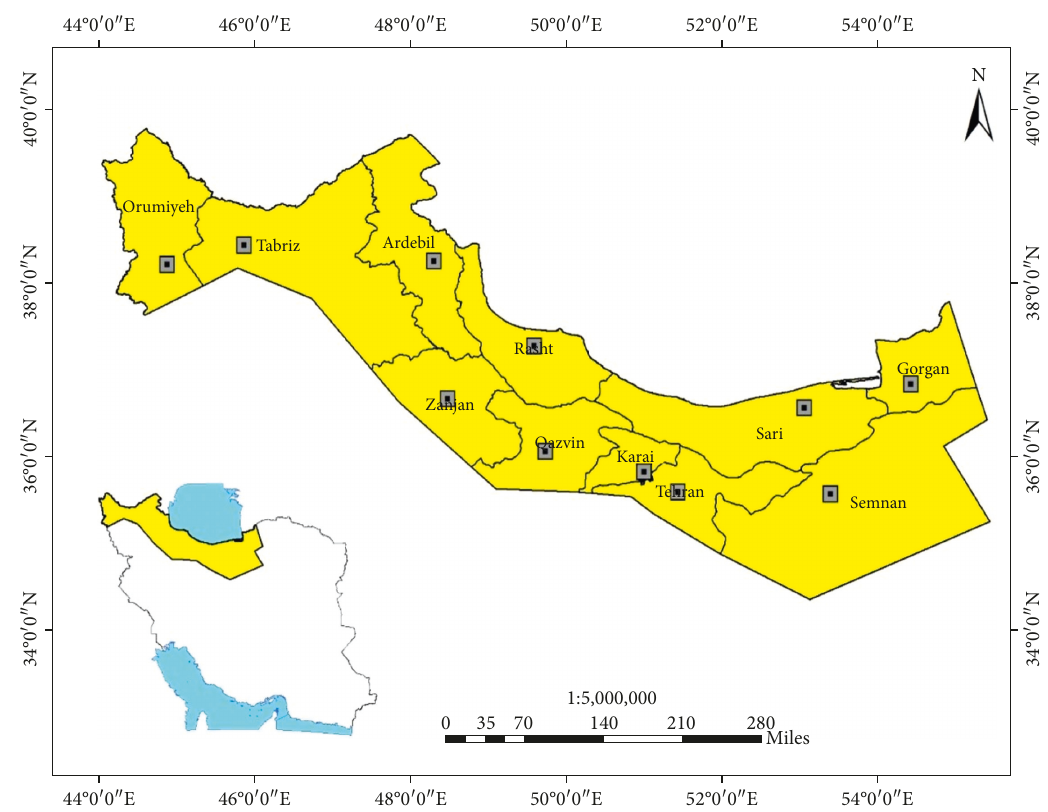
Figure 2: The Alborz-Azerbaijan province [43] which is the studied state in this article is marked in yellow.